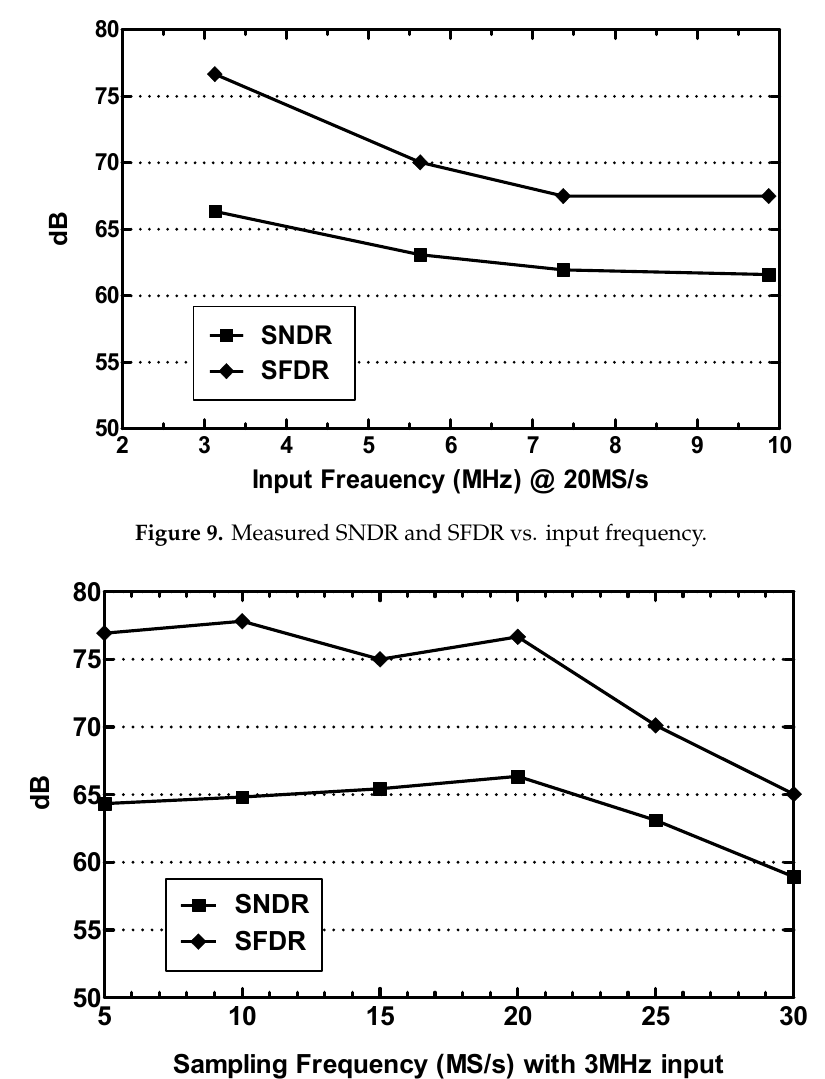
Figure 10. Measured SNDR and SFDR vs. sampling frequency.